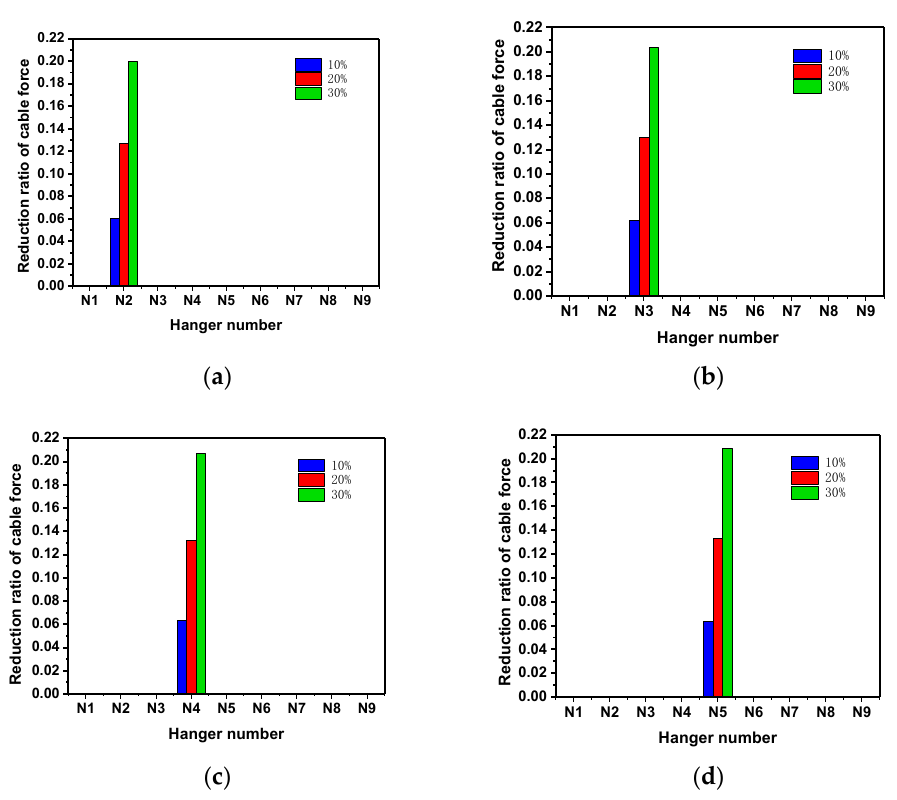
Figure 5. Identification results for DC1–DC12: ( a ) the preset damage hanger is N2; ( b ) the preset damage hanger is N3; ( c ) the preset damage hanger is N4; ( d ) the preset damage hanger is N5.